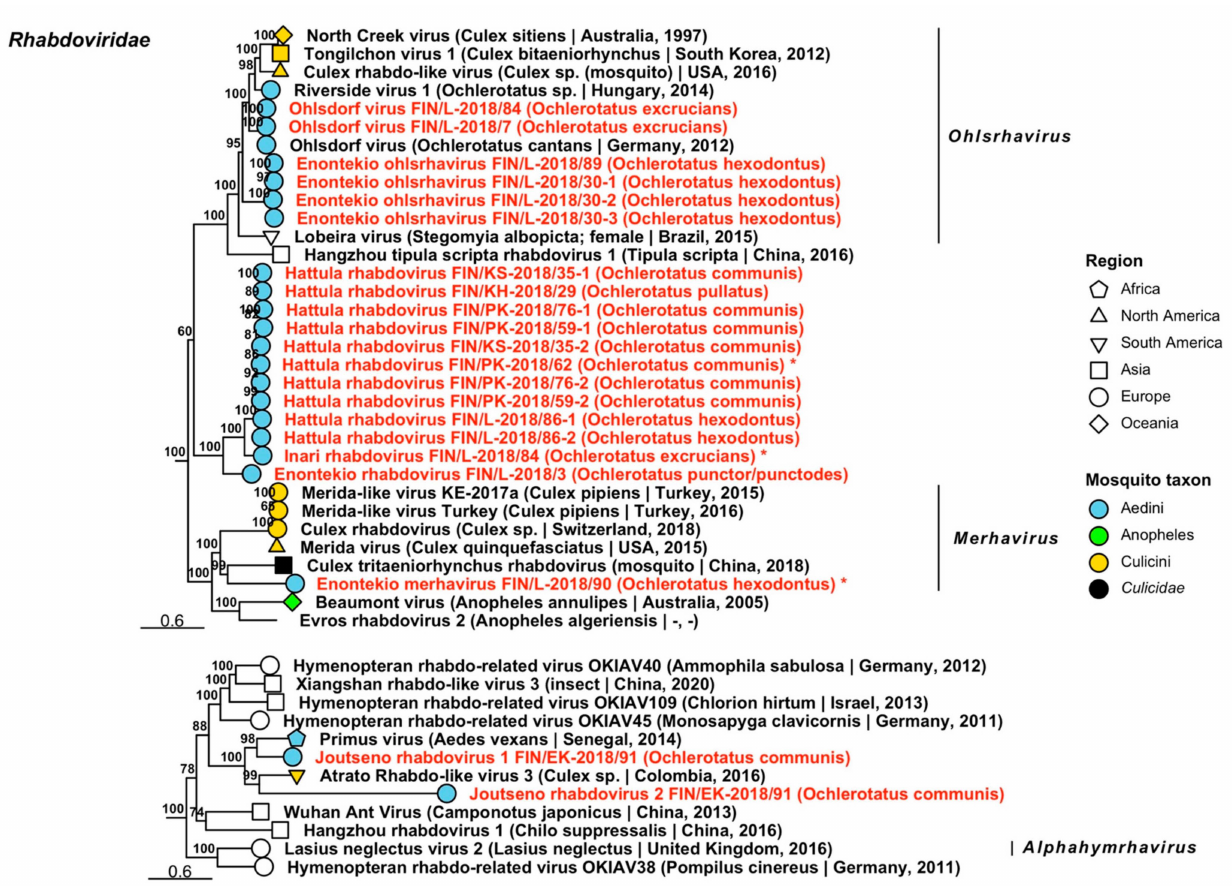
Figure 14. Maximum likelihood subtrees of Rhabdoviridae . Tentative novel viruses are displayed in red and the mosquito species from which they were derived are in parentheses. Sequences from GenBank are black and display the following information after the virus or species name: “(sampled organism(s)|collection country, collection year)”. Tip colours represent the tribe (Culicinae) or genus (Anophelinae) of mosquito from which viruses were obtained. Tip shape represents the continent or region from which the specimens were collected. Trees were constructed from amino acid sequences of virus polymerases >1000 nt, aligned with MAFFT and computed with IQ-TREE2 using ModelFinder and 1000 bootstraps. Asterisks denote that the complete genome was